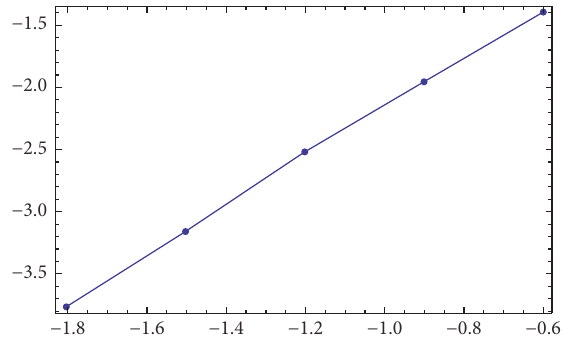
Figure 2: Plot of the decimal logarithm of the maximum error against log 10 Δ𝑡 . The number of points in space is fixed at 𝑁 = 2 12 . We see that the plot is approximately a line with slope